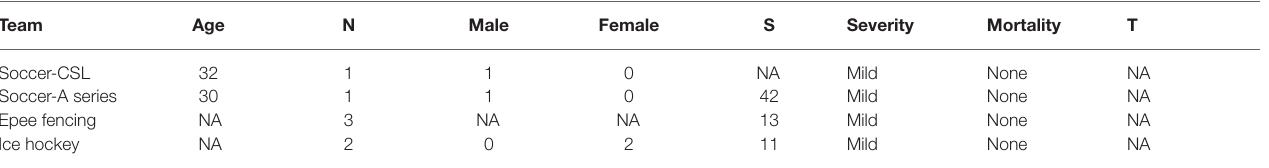
TABLE 1 | Characteristics of seven confirmed professional elite athlete patients with COVID-19. Team Age